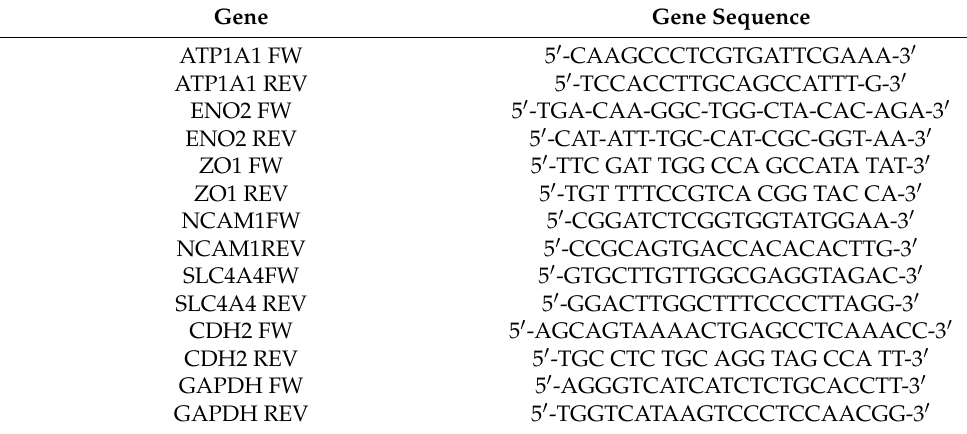
Table 2. Primers used in this